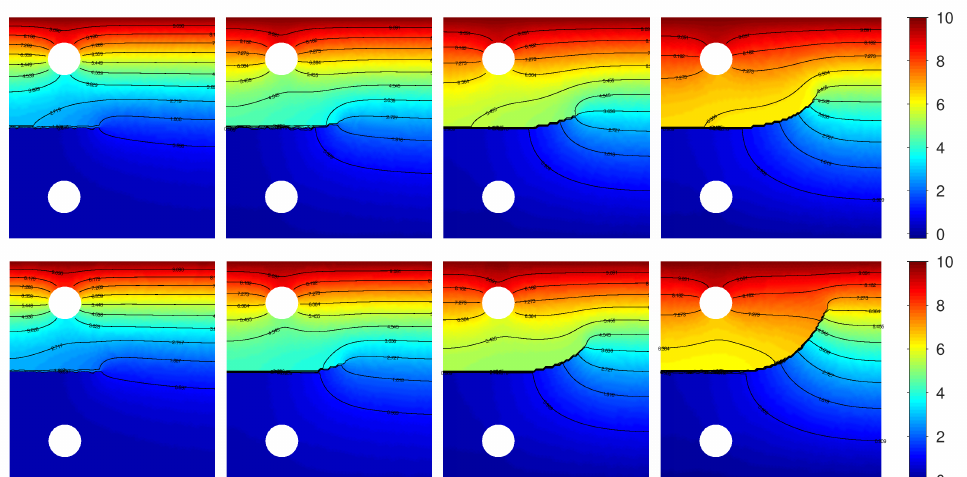
Figure 17. Snapshots of the temperature gradient during thermal expansion and crack growth under the given temperature Θ D = 10. TF-PFM1 ( top ) and TF-PFM2 ( bottom ) at t = 0.4, 0.6, 0.8, 1 ( left to right ); the color represents the value of Θ .